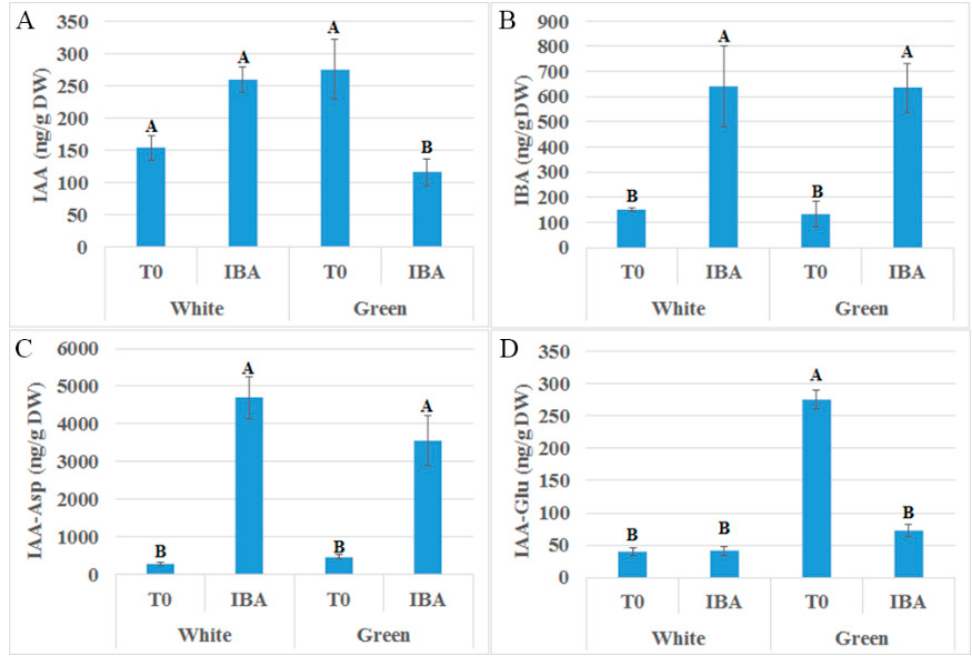
Figure 5. Auxin analysis. Cuttings were treated for 24 h with 60 ppm K-IBA and then incubated on rooting tables for an additional 24 h. Samples were quick-frozen in liquid nitrogen, ground and lyophilized at − 50 °C. Auxin content was determined in three replicates. ( A ) IAA, ( B ) IBA, ( C ) IAA-Asp, ( D ) IAA-Glu. T0, before K-IBA treatment; IBA, treated cuttings. Bars with different letters show significantly different results by Scheffe analysis p < 0.05.